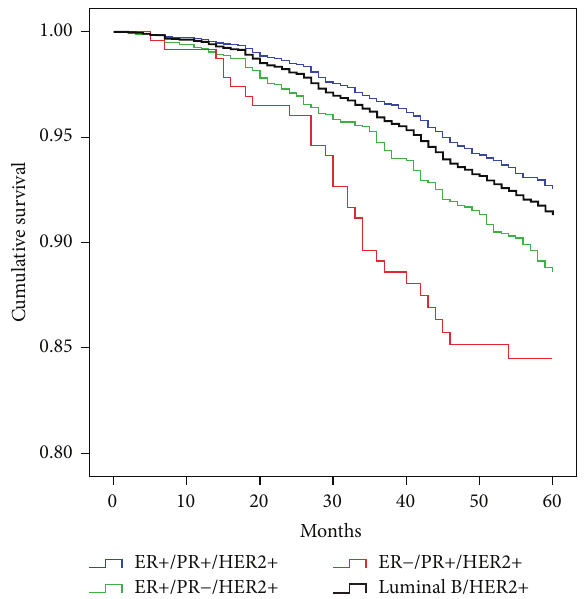
Figure 3: Survival of the luminal B/HER2+ IHC surrogate classifi- cation and its ER/PR/HER2 component subtypes for stage